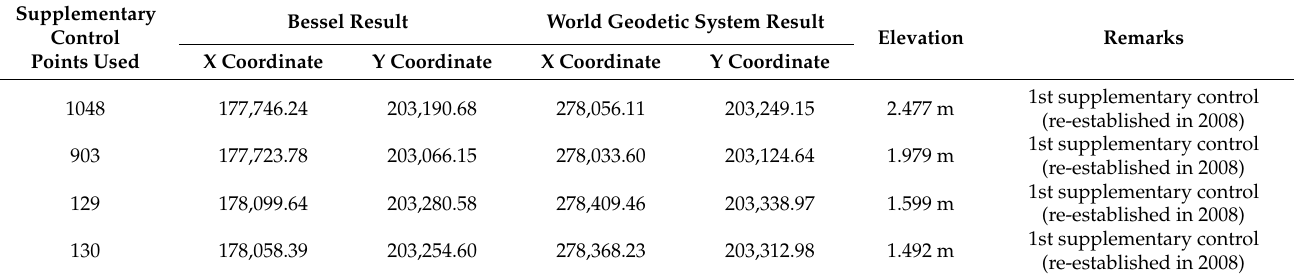
Table 3. Supplementary control points used in the